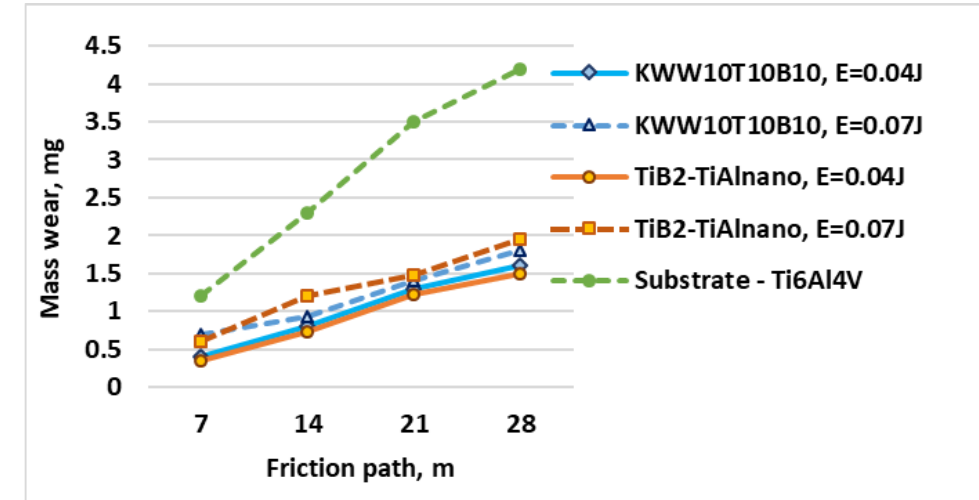
Figure 6. Mass loss of the tested coatings (abrasive wear).